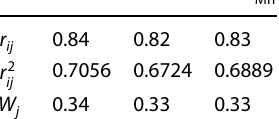
Table 2 Correlation coefficient of